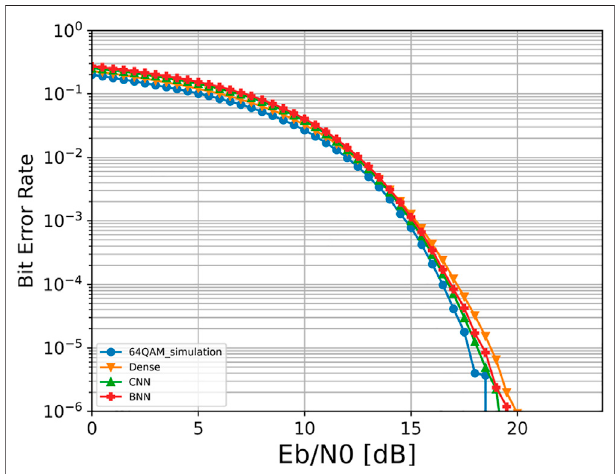
FIGURE 6 | Performance comparison under